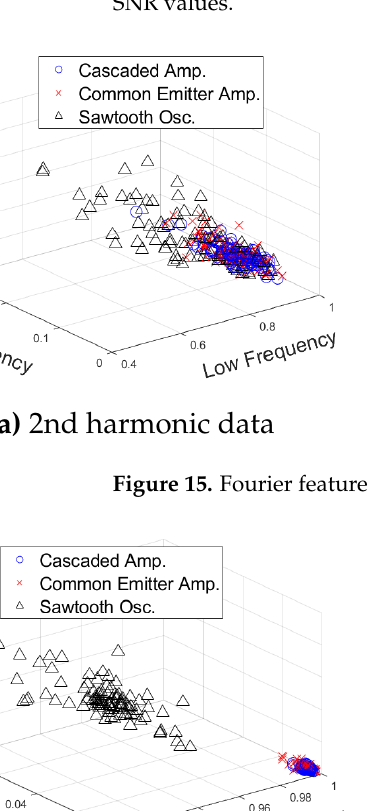
Version June 4, 2022 submitted to Remote Sens.